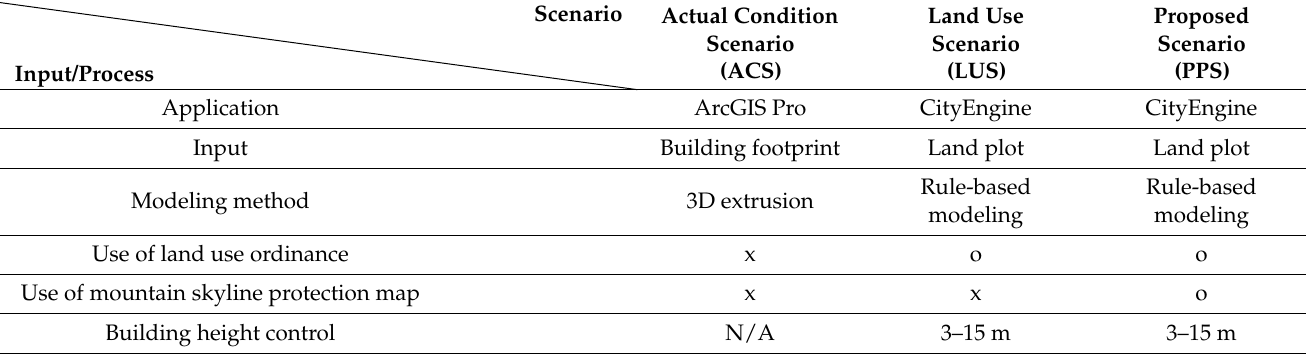
Table 2. Input parameter and factors to generate 3D modelling by